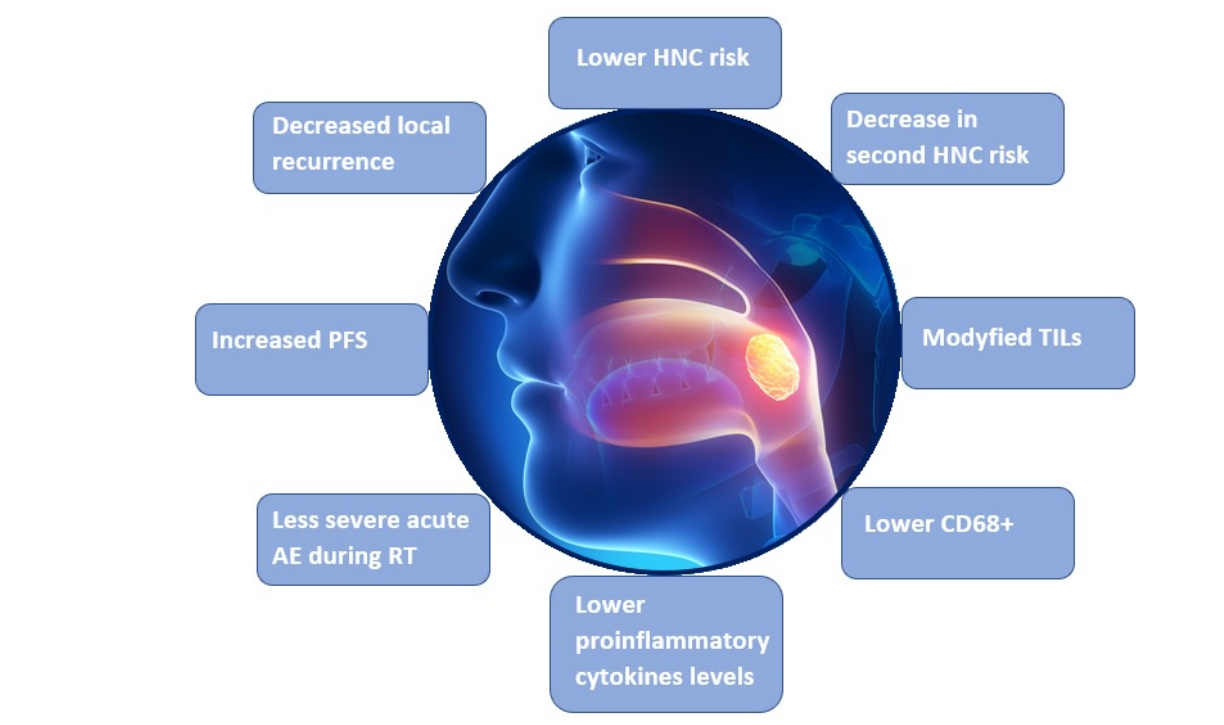
Figure 3. The most important results regarding effects of carotenoids in the reviewed studies. HNC: head and neck cancer; PFS: progression-free survival; TILs: tumor infiltrating lymphocytes; AE: adverse effects.